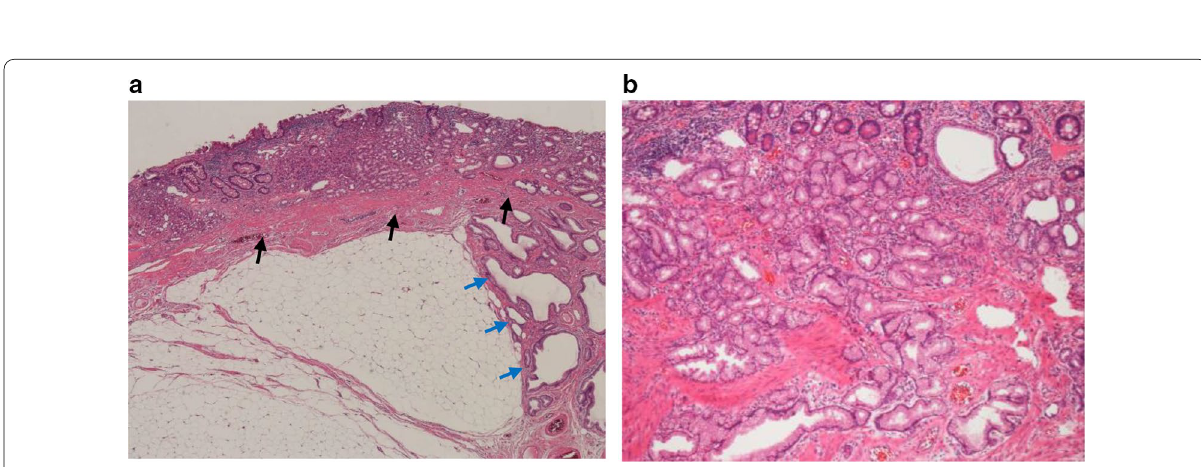
Fig. 3 Histological findings. a HE ( 40). Growth of mature adipose tissue was observed in the submucosa of the area of tumor onset. The × muscularis mucosae (black arrow) and GCP-like glandular ducts were observed in the submucosal area (blue arrow). b HE ( mucosa-like crypt epithelium and proper glandular tissue was found in the small intestine epithelium. Signs of dilatation of the deeper parts of the gastric pit over the submucosa and hyperplasia of the crypt epithelium were